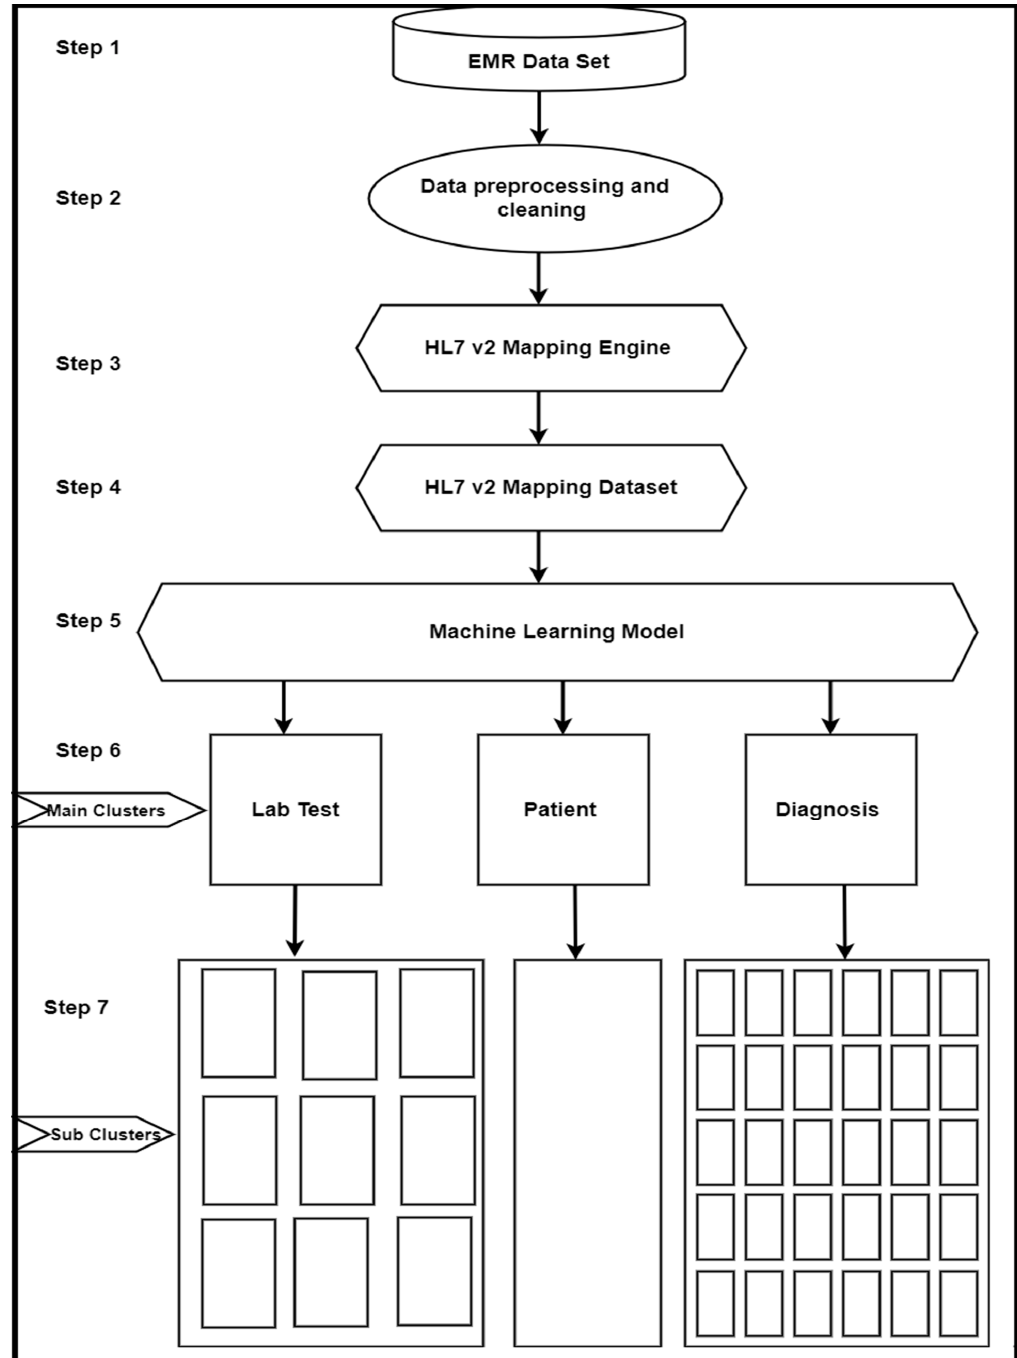
Figure 1. Framework architecture.